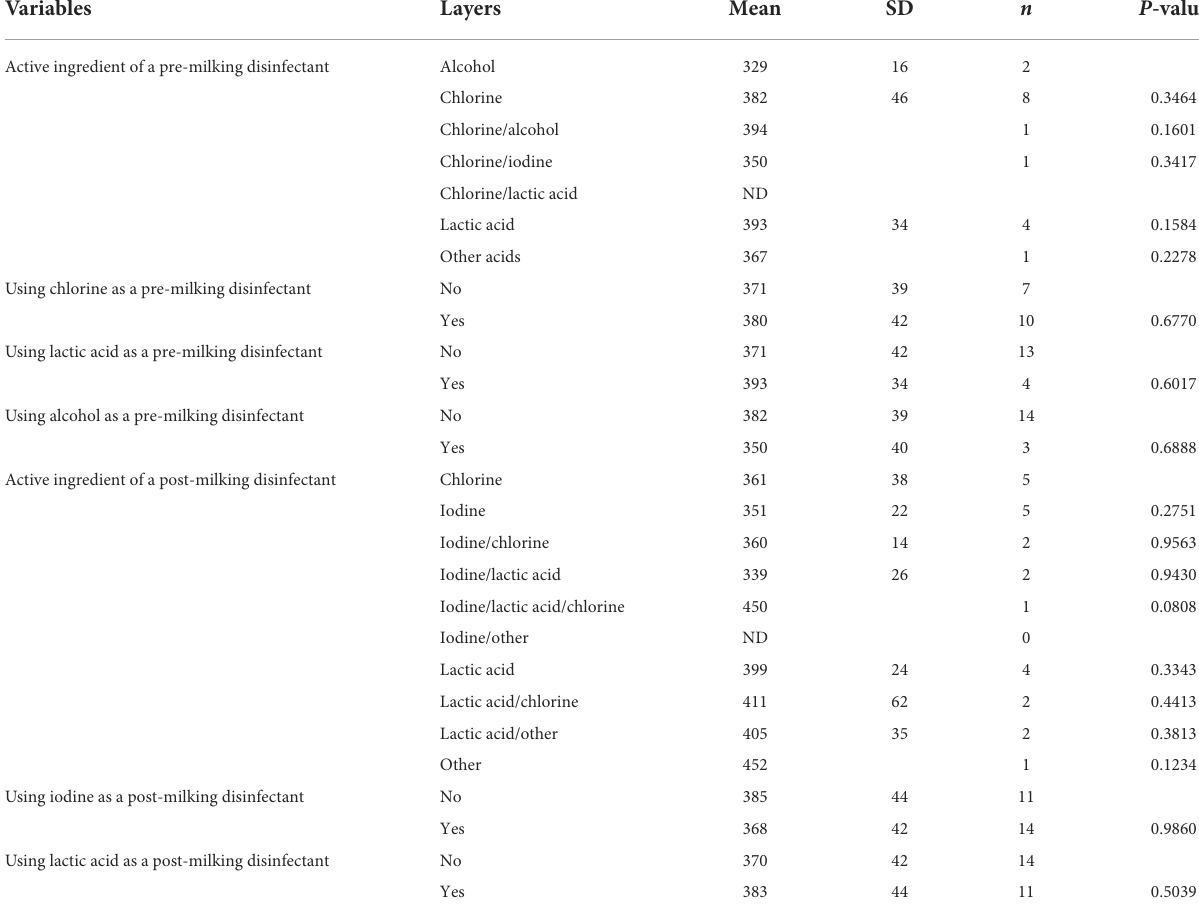
TABLE 6 Relationships between Days in Milk (days) and pre- and post-milking disinfectants. Variables Layers Mean SD n P